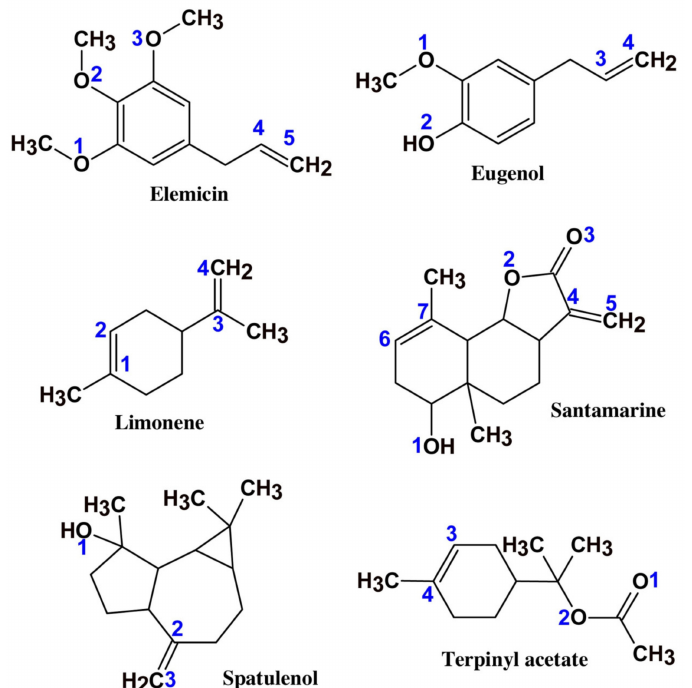
Figure 11. Geometry of neutrally charged elemicin, eugenol, limonene, santamarine, spatulenol, and terpinyl acetate compounds found in Laurus nobilis leaf extract, the oxygen and carbon atoms chosen for protonation are indicated in blue. (Reprinted with permission from Ref. [213]. Copyright 2020 Elsevier